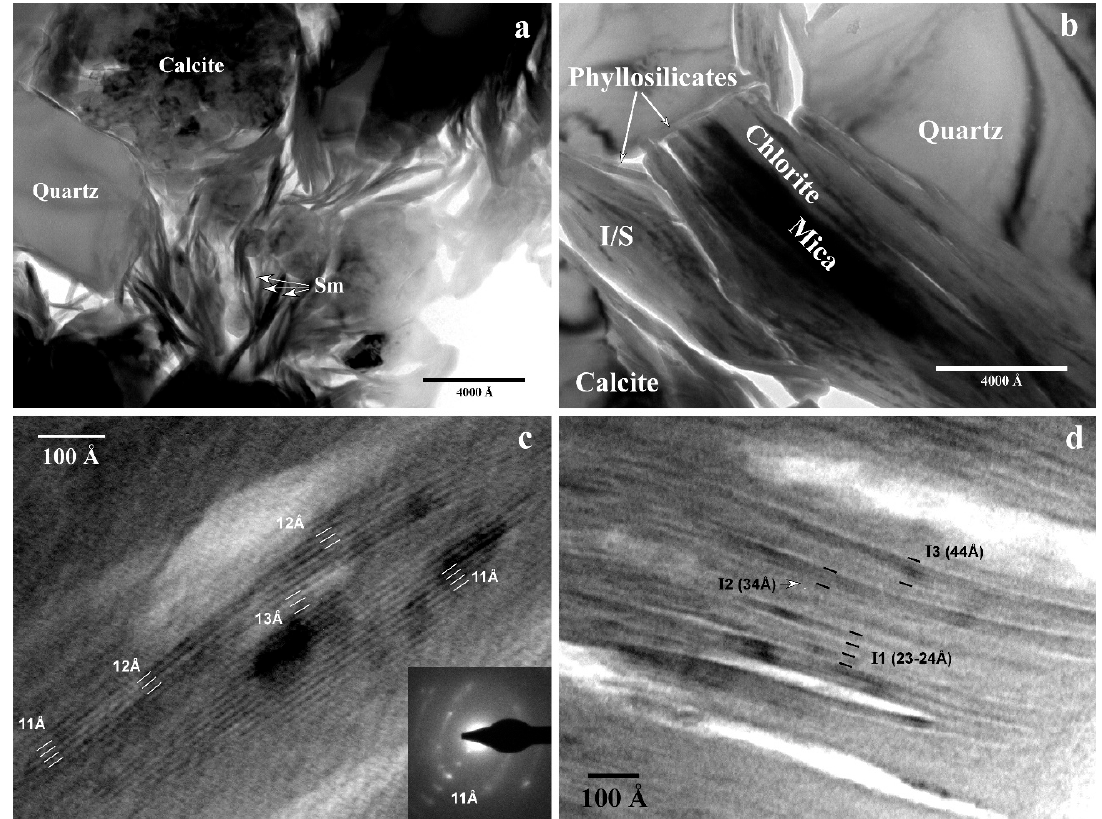
Figure 5. Low-magnification TEM images: ( a ) Sample from the top of section R0 (1CS6); ( b ) sample from section R1 (3CS6). The central grain shows an intergrowth of mica and chlorite. On the left is a package of lens-shaped I/S mixed layers. Note the lower microporosity of this R1 sample compared to the R0 sample; ( c ) HRTEM image of 1CS6 with anastomosing packets of smectite. The Selected Area Electron Diffraction (SAED) image reveals disordered polytype in a turbostratic arrangement; ( d ) lattice image of 3CS6 (bottom of section R1) with ordered I/S mixed layers, some with excess illite layers (I2 and I3).